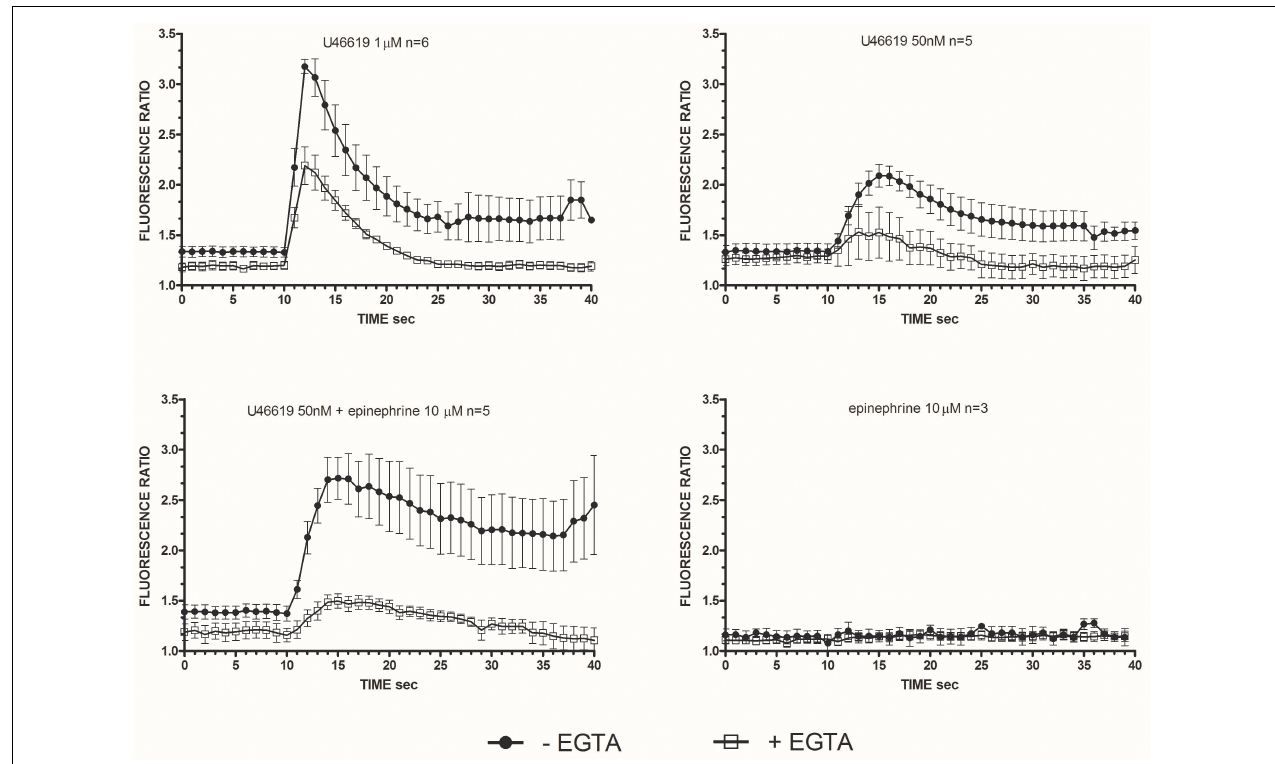
FIGURE 3 | Intracellular Ca 2 + release in stimulated washed platelets in presence/absence of extracellular calcium. Washed platelets in non-aggregating condition (eptifibatide 10 µ g mL − 1 , ASA 100 µ M, apyrase VII 10 U mL − 1 ) were stimulated by U46619 1 µ M, U46619 50 nM, U46619 50nM + epinephrine 10 µ M, and epinephrine 10 µ M. Fluorescent emission at 510 nm was measured induced by double excitation wavelength of 340 and 380 nm. The ratio of the two fluorescence is proportional to the concentration of the released intracellular calcium. Repeated-measures Two-Way ANOVA was applied to compare the effects of platelets agonists at different time points. Significant differences ( P < 0.0001) were observed comparing intracellular Ca 2 + release induced by U46619, but not epinephrine ( P = n.s.), with and without EGTA. Data are expressed as Mean ± SE.